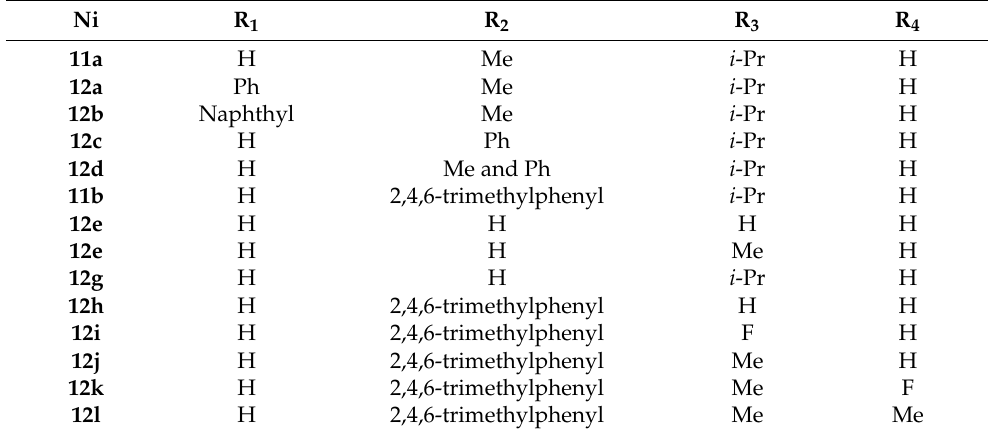
Table 1. The various substituents (R) of amine–pyridine nickel complexes (Figure 8). Ni